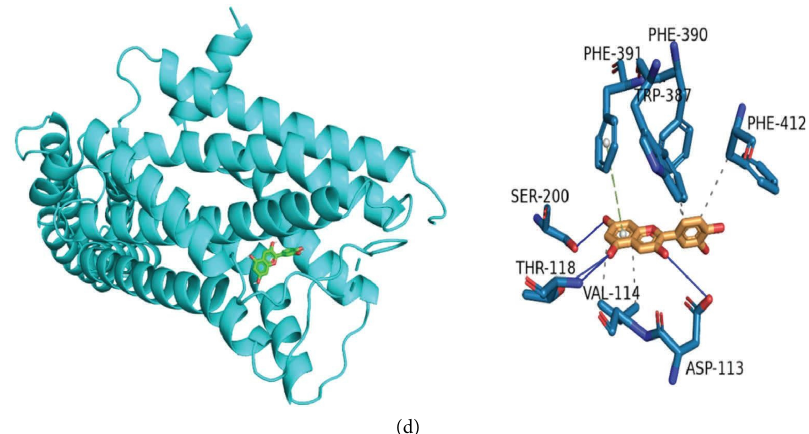
Figure 6: Molecular docking results. (a) Stigmasterol-NR3C2. (b) Glycyol-NCOA2. (c) Estrone-MAOA. (d)